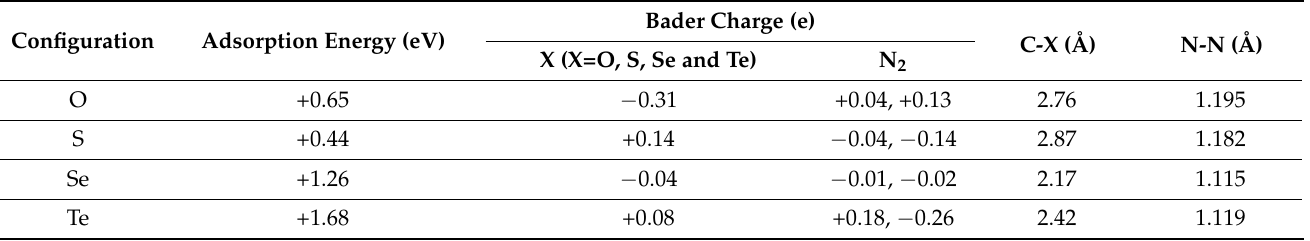
Table 4. Calculated adsorption energies, Bader charges on the N 2 molecule and adsorbed atoms (X), and bond distances (C-X and